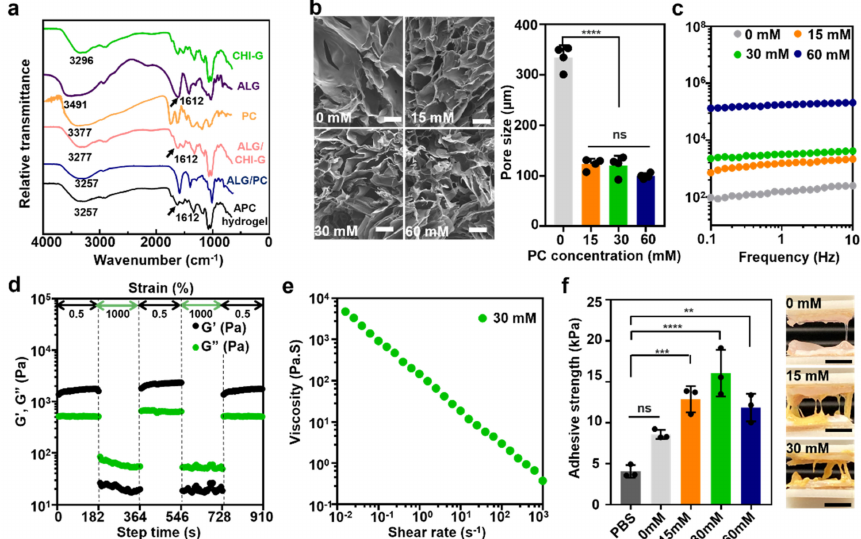
Figure 3. Physicochemical characterization and rheological properties of APC hydrogels. ( a ) FT-IR spectra of CHI–G (green), ALG (violet), PC (orange), ALG/CHI–G (pink), ALG/PC (blue) and APC hydrogel (black). ( b ) Cross-sectional SEM images of the APC hydrogels containing PC with different concentrations (0, 15, 30, and 60 mM) ( left ) and their pore sizes ( right ) ( n = 4). Scale bar: 100 µ m. ( c ) Frequency sweep-storage (G (cid:48) ) moduli at 2% strain, 25 ◦ C of 0 mM (gray), 15 mM (orange), 30 mM (green), and 60 mM (blue) PC-containing APC hydrogels. ( d ) Self-healing properties and ( e ) shear-thinning performance of 30 mM APC hydrogel. ( f ) Adhesive strengths of hydrogels with different PC concentrations. ( n = 3) Scale bar: 10 mm. All statistical significance and p values are determined by one-way ANOVA followed by Tukey’s post-hoc test. **** p < 0.0001; *** p < 0.001, ** p < 0.01; ns denotes not